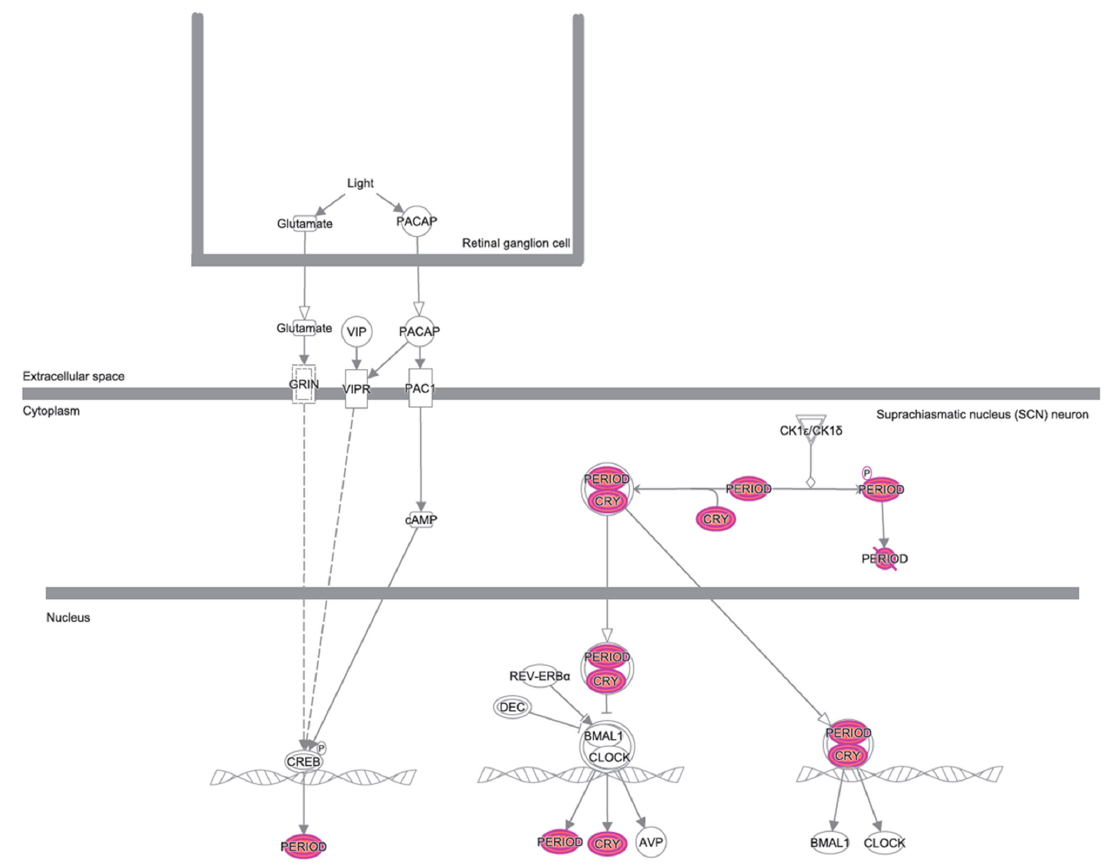
Figure 5. The circadian rhythm pathway identified as one of the significant pathways by the IPA. The genes of the up-regulated RS vs. CTRL are highlighted in pink.